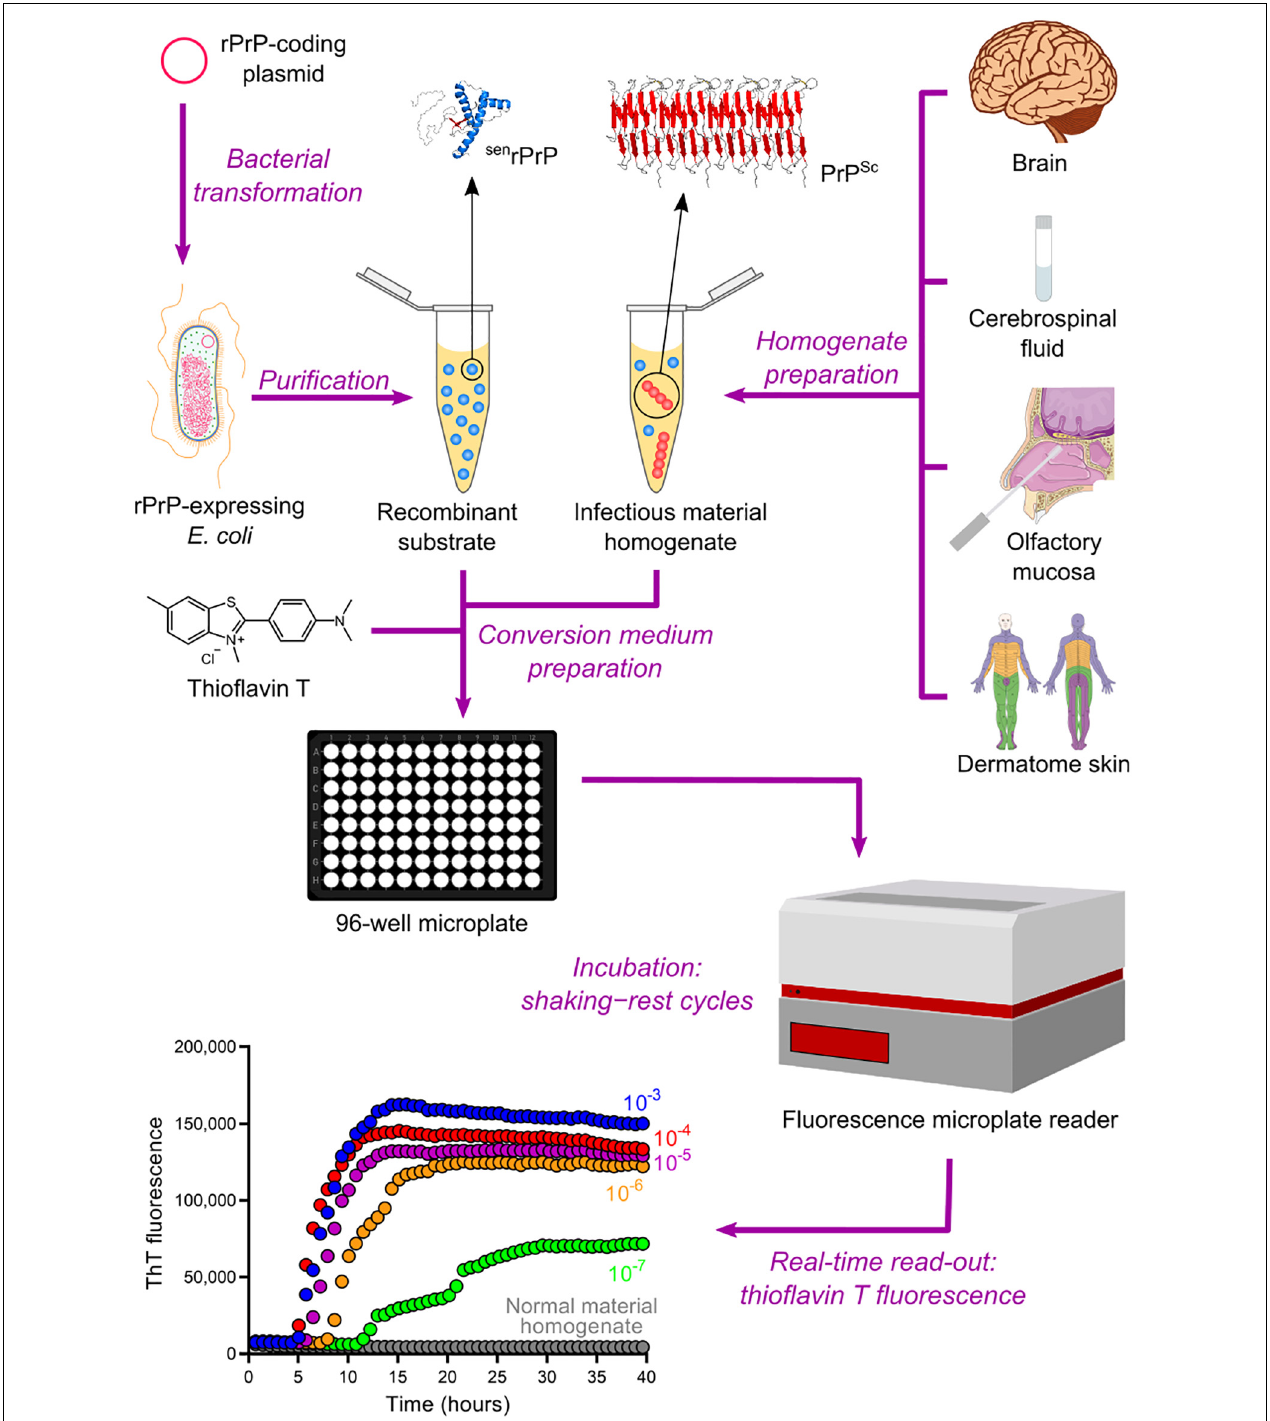
FIGURE 4 | Real-time quaking-induced conversion (RT-QuIC). Recombinant PrP (rPrP) is expressed heterologously in E. coli and purified as folded protease-sensitive rPrP ( sen rPrP), the substrate for RT-QuIC. Suspected infectious material homogenate, a possible source of PrP Sc (seed), is prepared from brain sections, cerebrospinal fluid, olfactory mucosa brushings, and dermatome skin sections. High dilutions of a test sample are mixed with sen rPrP, buffer, and thioflavin T (a fluorescent amyloid probe) to produce the conversion medium, which is loaded into a multiwell microplate and then incubated with alternating cycles of shaking and rest in a fluorescence microplate reader. This equipment records thioflavin T fluorescence emission throughout the incubation, thus revealing the kinetics of aggregate formation. A sigmoidal growth in thioflavin T fluorescence indicates a positive TSE diagnosis. The use of normal material homogenate does not lead to any increase in thioflavin T fluorescence, indicating that no conversion is happening. The positive result shown was obtained with brain homogenate from a patient with GSS.